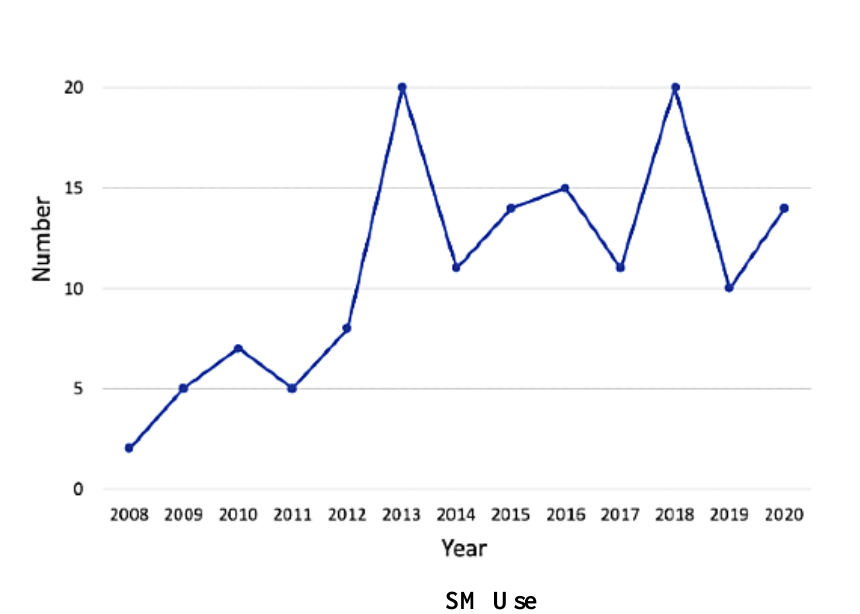
Figure 2. Number of included publications per